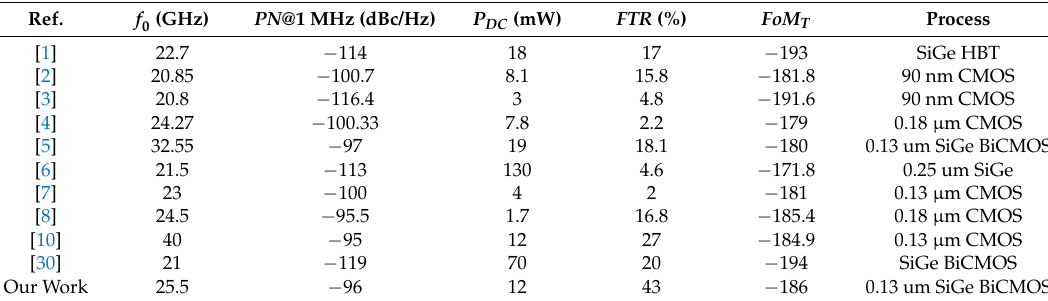
Table 1. Comparison of reported K / K a band DVCOs and this work.